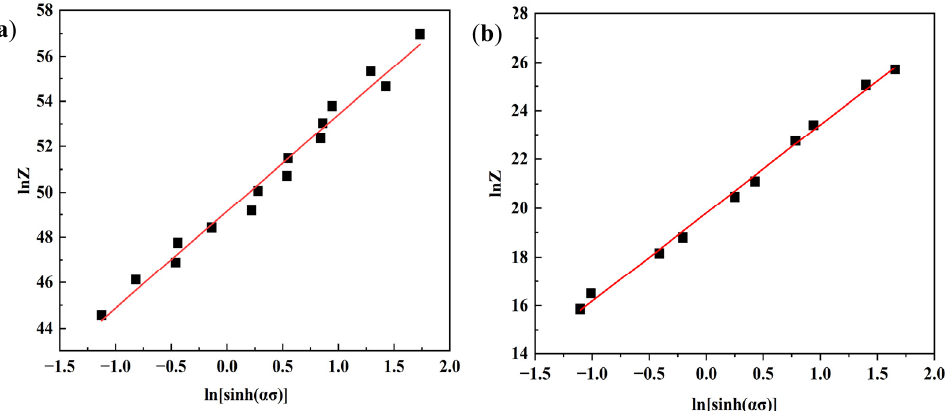
Figure 7. Curves of ln[sinh( ασ )] − ln Z at different phase fields: ( a ) α + β and ( b ) β . Moreover, the correlation coefficient of ln[sinh( ασ )] − ln Z at α + β and β phase fields Table 3. Parameters for constitutive relations. can be determined as 0.98 and 0.9958, respectively, which show the hyperbolic sinusoidal function coincides with the experimental data. The constitutive equations of the alloy are expressed as shown in Equation